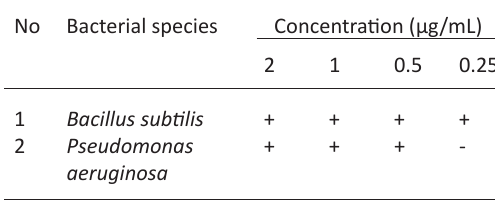
Fig. 2. FTIR spectroscopy of crude silver nanoparticles